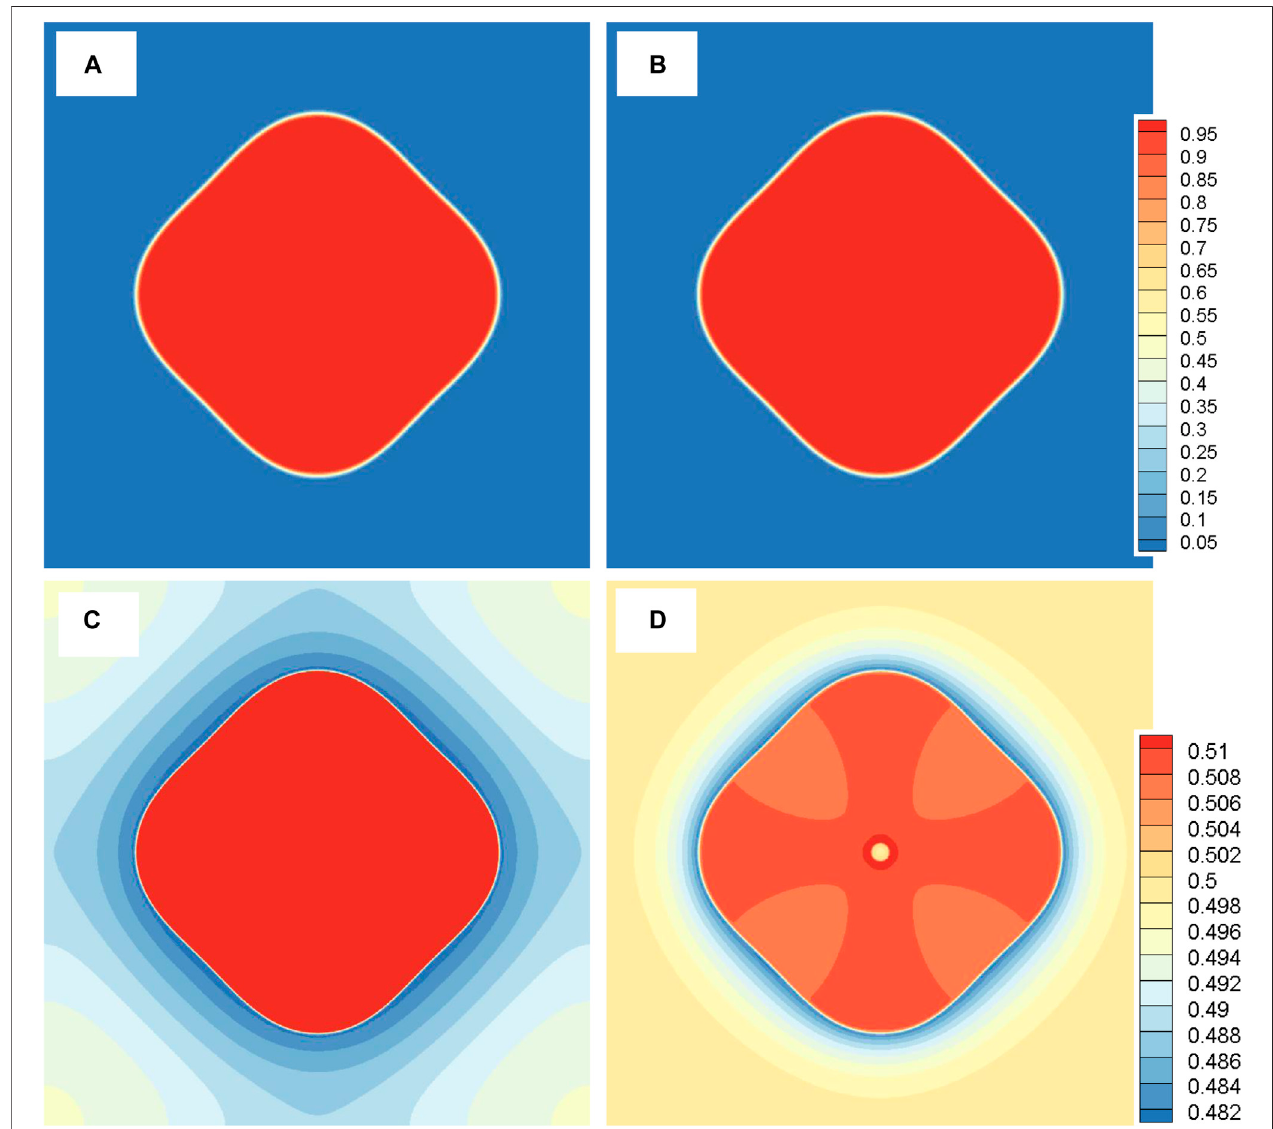
FIGURE8| (coloronline)Snapshotsofthemicrostructuredisplayedbyphase fi eld (A) TDB1 (B) TDB2andconcentration fi eld (C) TDB1 (D) TDB2atthesamesolid fraction as 30%.